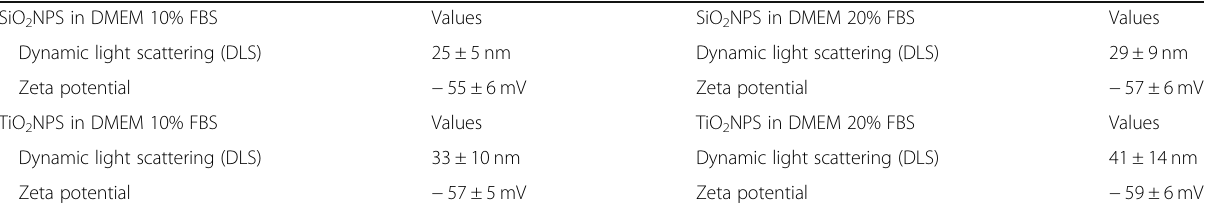
Table 1 Characterization of SiO 2 NPs and TiO 2 NPs in DMEM supplemented with 10% and 20% of FBS SiO 2 NPS in DMEM 10%